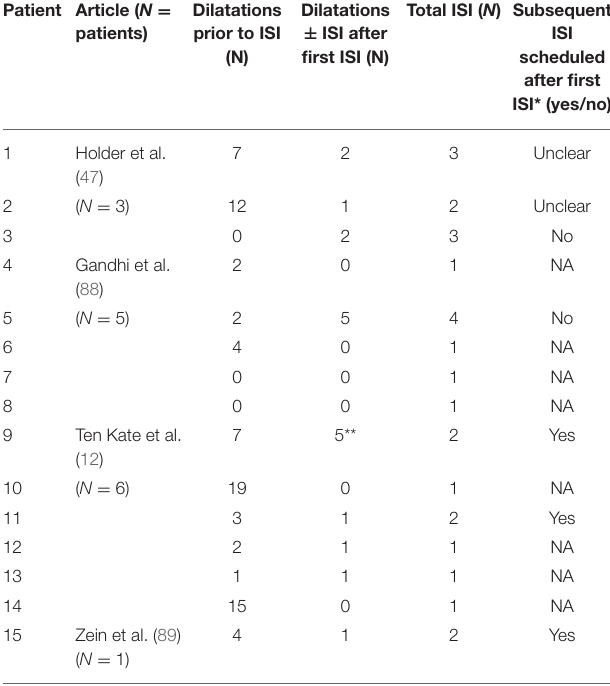
TABLE 2 | Summary of dilatations and ISI per